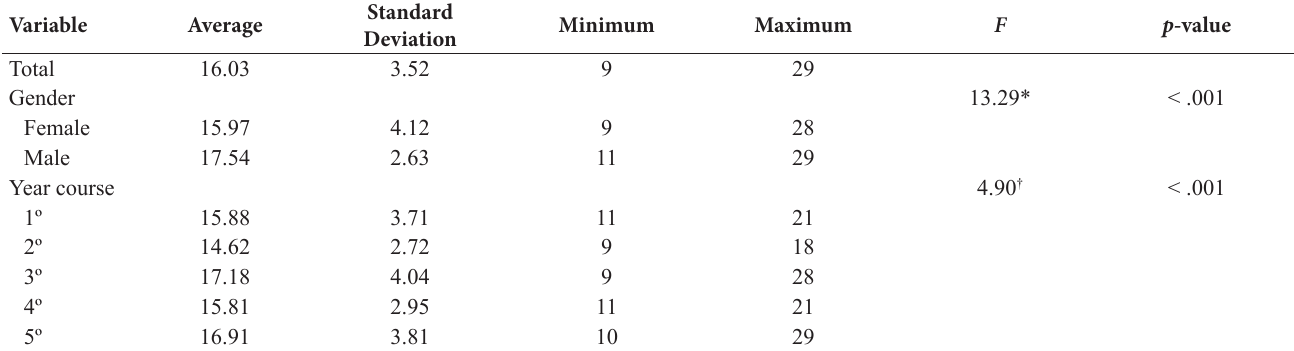
Table 1. Comparison of coronary risk scores by year of study and gender. Variable